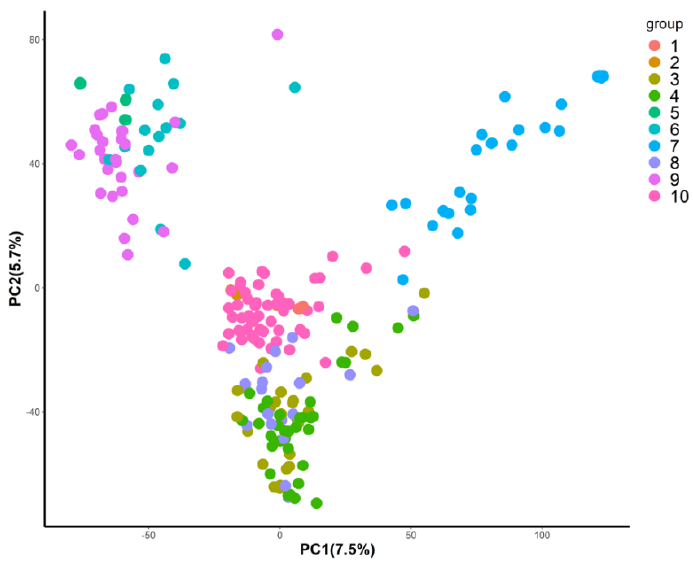
Figure 1. Stratification of genomic prediction panel inferred from discriminant analysis of principal components (DAPC) using 27,957 SNPs data. The first two principal components (account for variance of 7.5% and 5.7%, respectively) are used to represent each line in the genomic prediction (GP) panel. Each line was colored based on the posterior of probability assigned to 10 genetic groups inferred from DAPC.